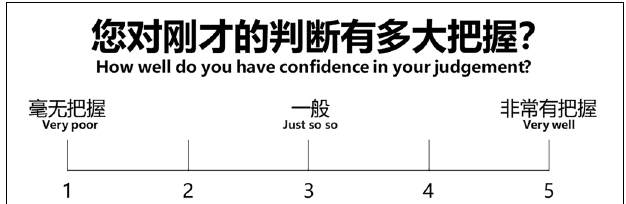
FIGURE 10 | Rating